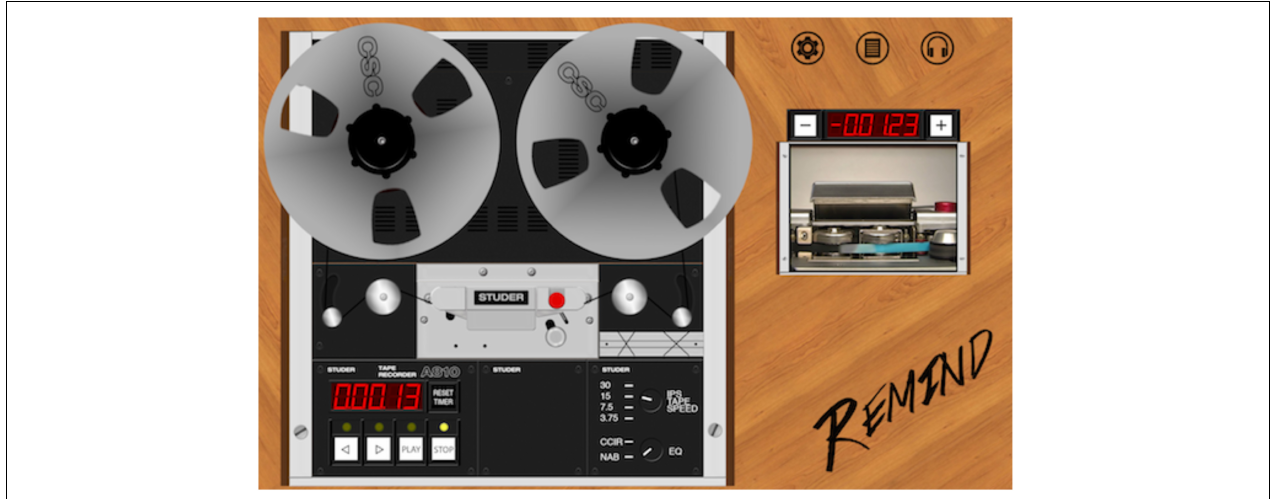
FIGURE 2 | The main graphic user interface of the REMIND app. A video of the original tape is shown outside the body of the tape recorder (top right inset) to improve its